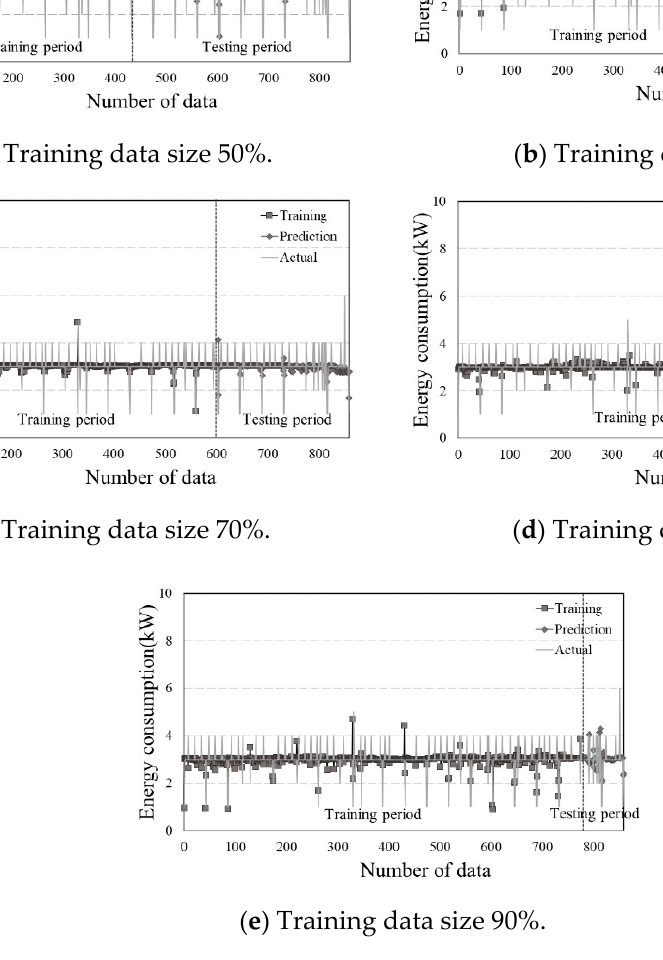
Figure 4. Air handling unit energy consumption forecast results. Table 3. Air handling unit energy consumption forecasting results: error rate and standard deviation.